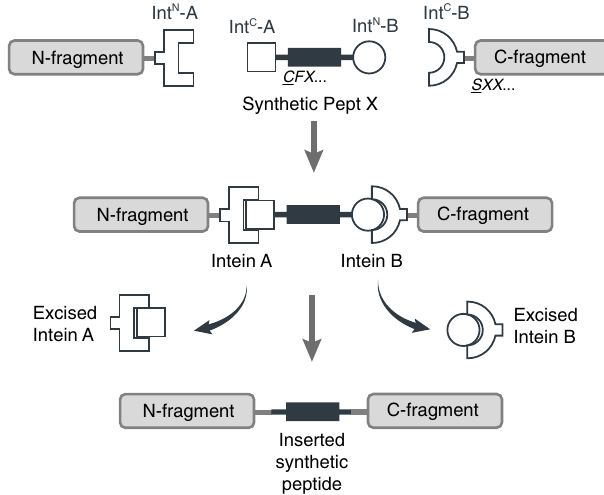
Fig. 1 Schematic diagram of the tPTS strategy to incorporate recombinant and synthetic proteins. The chosen split inteins used in this study, inteins A ( Cfa DnaE) and B ( Ssp DnaB M86 ), are indicated by square and round symbols, respectively. Flanking + 1, + 2, + 3 extein residues for each intein are indicated in italics at their respective positions in the top panel. The + 1 extein residue (underlined) is a critical requirement for splicing to occur. X denotes that the type of residue at that position is not critical for splicing, although they might affect the kinetics or splicing ef fi